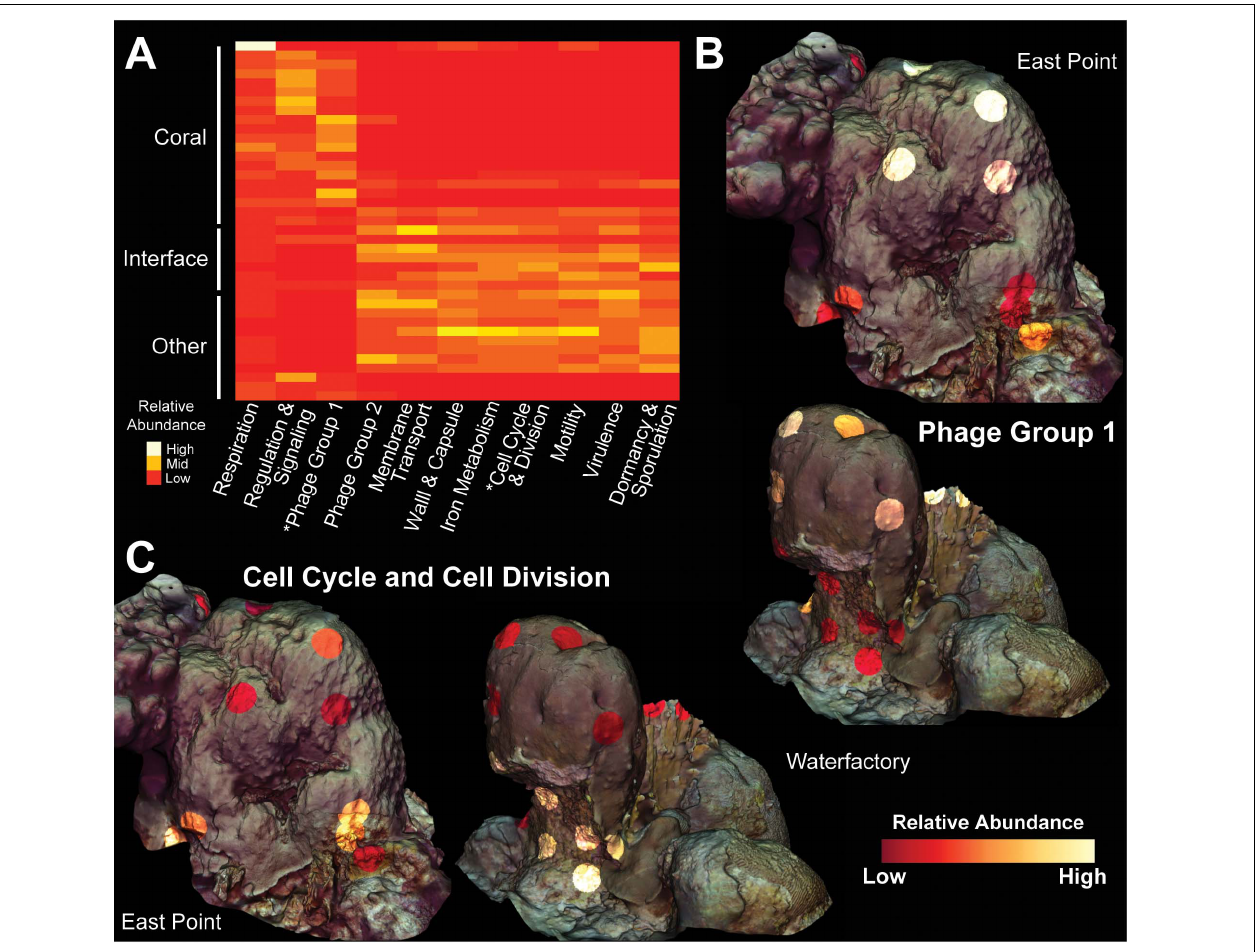
FIGURE 6 | Molecular heatmap of bacterial metatranscriptomes from Orbicella faveolata colonies, competitors and interfaces. (A) Heatmap of SEED Level 1 categories selected from the supervised random forests analysis. Phage Group 1 includes phages, prophages and transposable elements while Phage Group 2 also includes plasmids. Colors are normalized to columns with red representing the lowest relative abundance and white representing the highest. Asterisks highlight Level 1 categories shown in 3D models. 3D coral models mapped with the relative abundance of bacterial transcripts belonging to (B) Phage Group 1 and (C) Cell Cycle and Cell Division at both sampling sites. The relative abundance of Phage Group 1 transcripts range from 0.06–0.74% at East Point and 0.002–0.42% at Water Factory. For Cell Cycle and Cell Division, the relative abundances range from 0.03–0.53% at East Point and 0.02–0.28% at Water